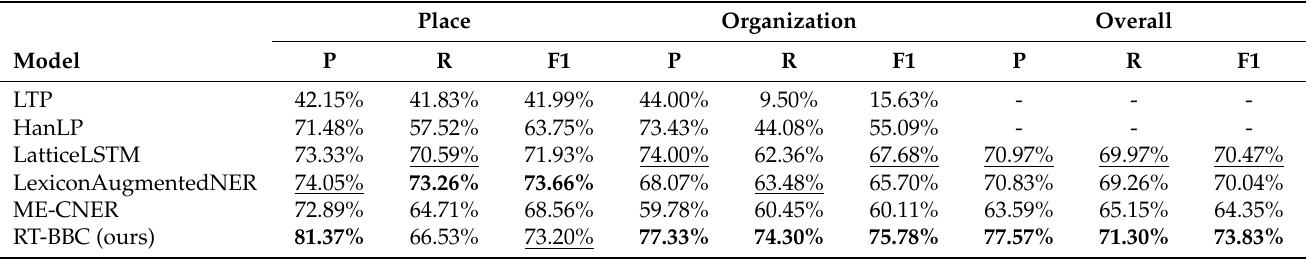
Table 3. Comparison of